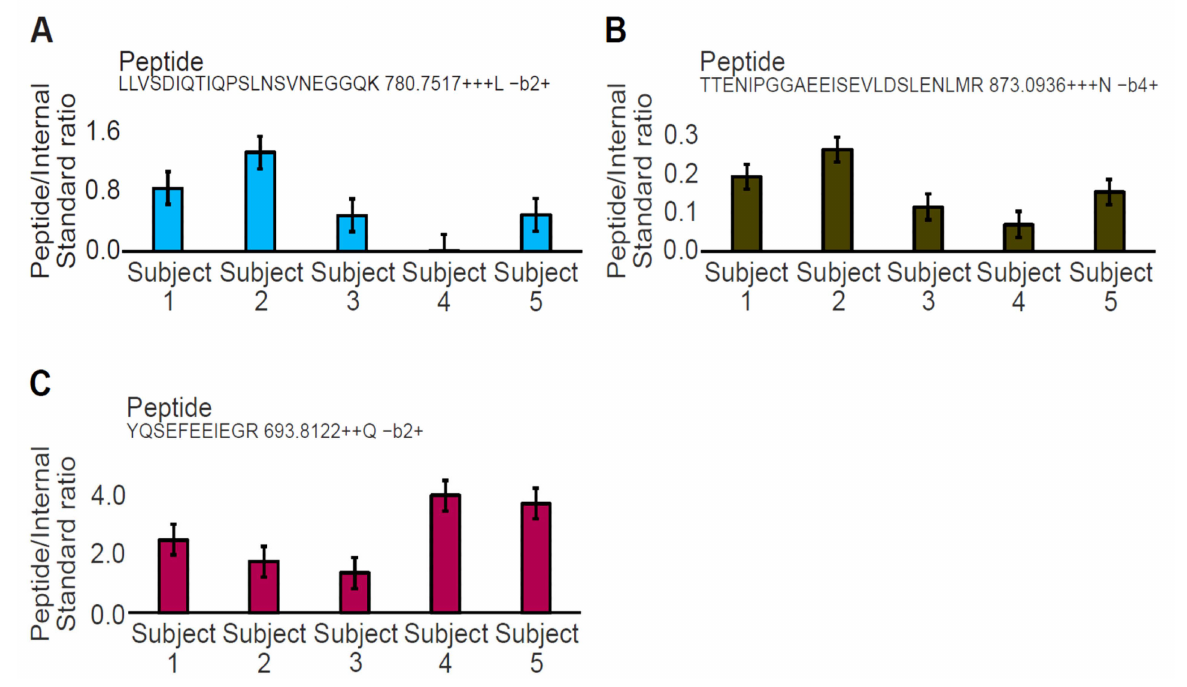
Figure 3. Quantitation of the three DMD tryptic peptides in plasma across 5 healthy control samples. Graphs ( A , B ) are related to the tryptic peptides LLV and TTE of the D1 (R6–R7) and the D2 PrESTs (R8–R10), respectively. Graph ( C ) is related to the tryptic peptide YQS of the D1 PrESTs (R6–R7). The 3 tryptic peptides have different expression profiles across each subject and do not correlate. Transition information used for quantitation is given with the peptide sequence for each graph.